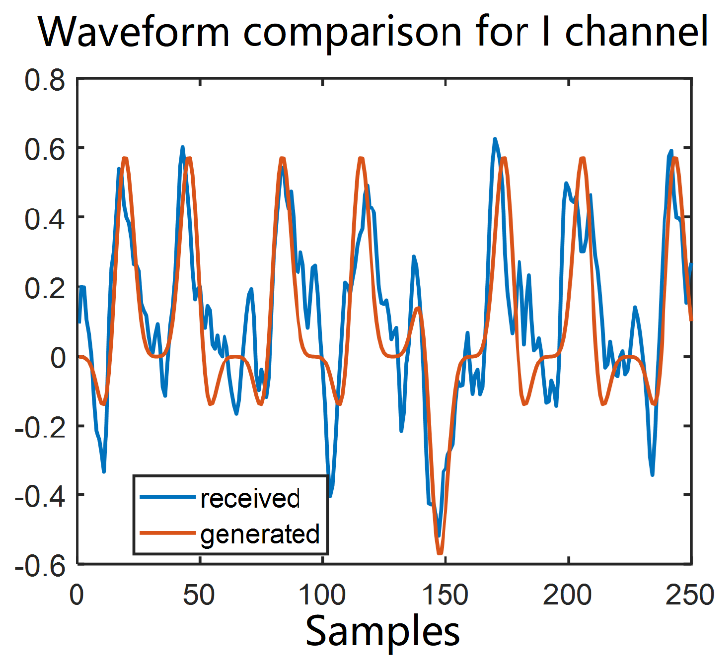
Figure 6. Comparison of received and transmitted waveforms.